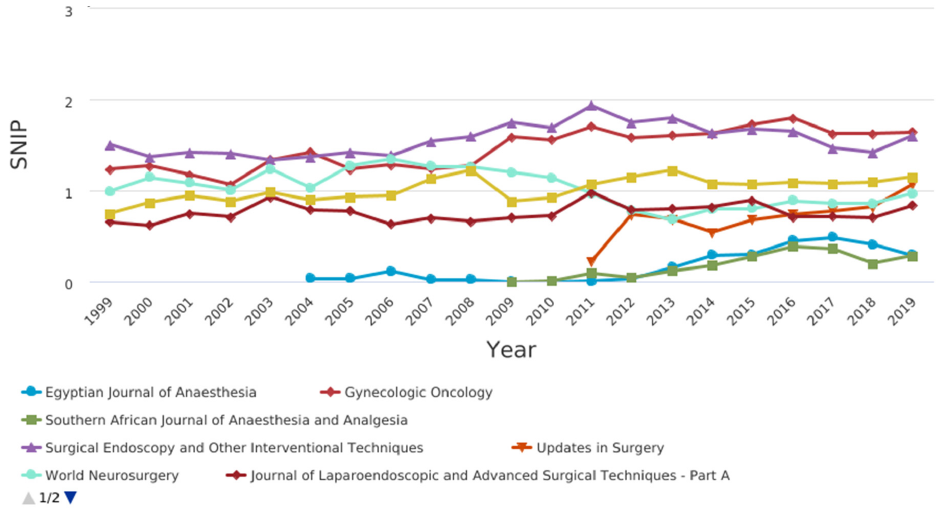
Figure 8. Source-normalized impact per paper SNIP) of pain, anesthesia, and surgery journals.